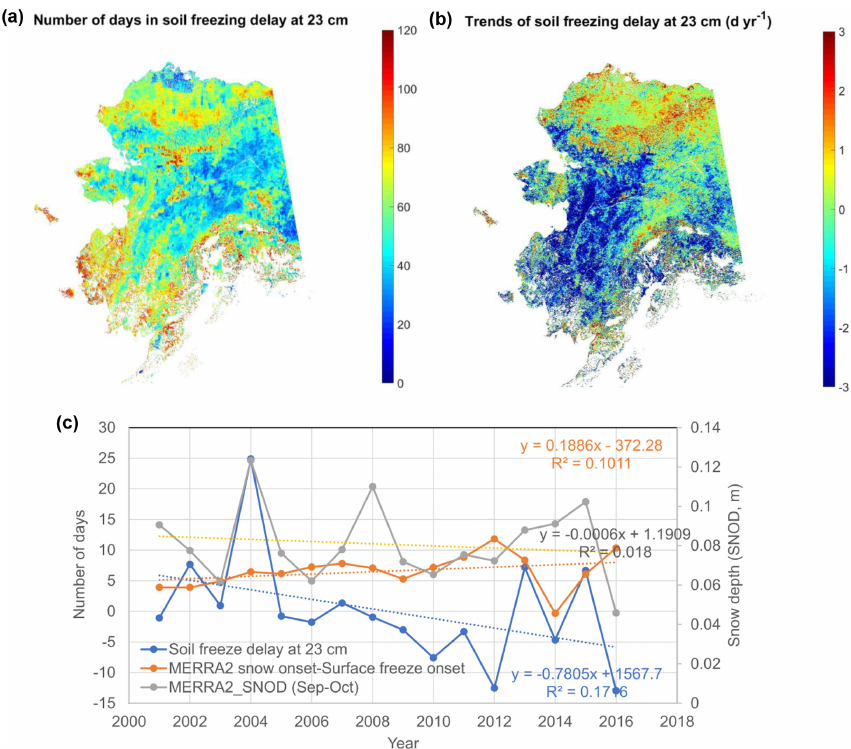
Figure 12. Sensitivity of model-simulated soil-freezing process to snow cover changes across Alaska. The mean (a) and trends (b) of the soil-freezing delay at 23cm soil depth relative to surface freeze onset. (c) The annual time series of the model-simulated soil-freezing delay, the number of snow-free days after land surface freezes, and MERRA-2 snow depth (SNOD) from September to October, averaged across